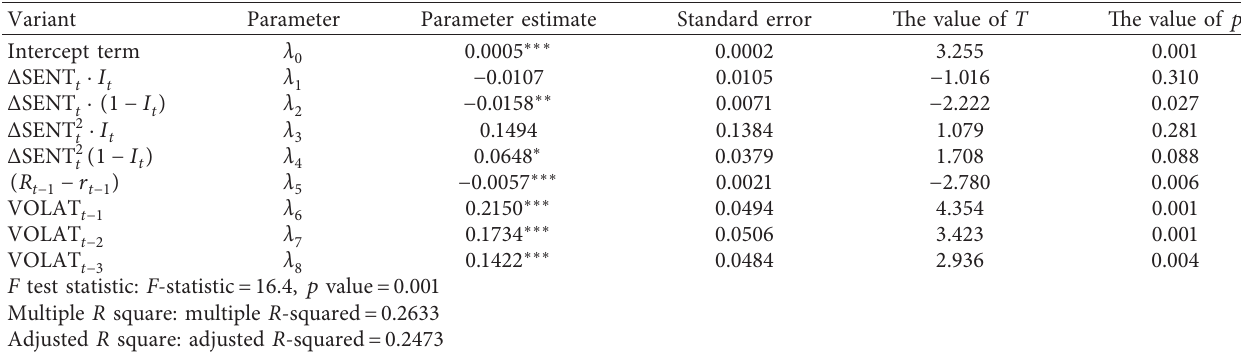
Table 3: Linear regression results of OLS.